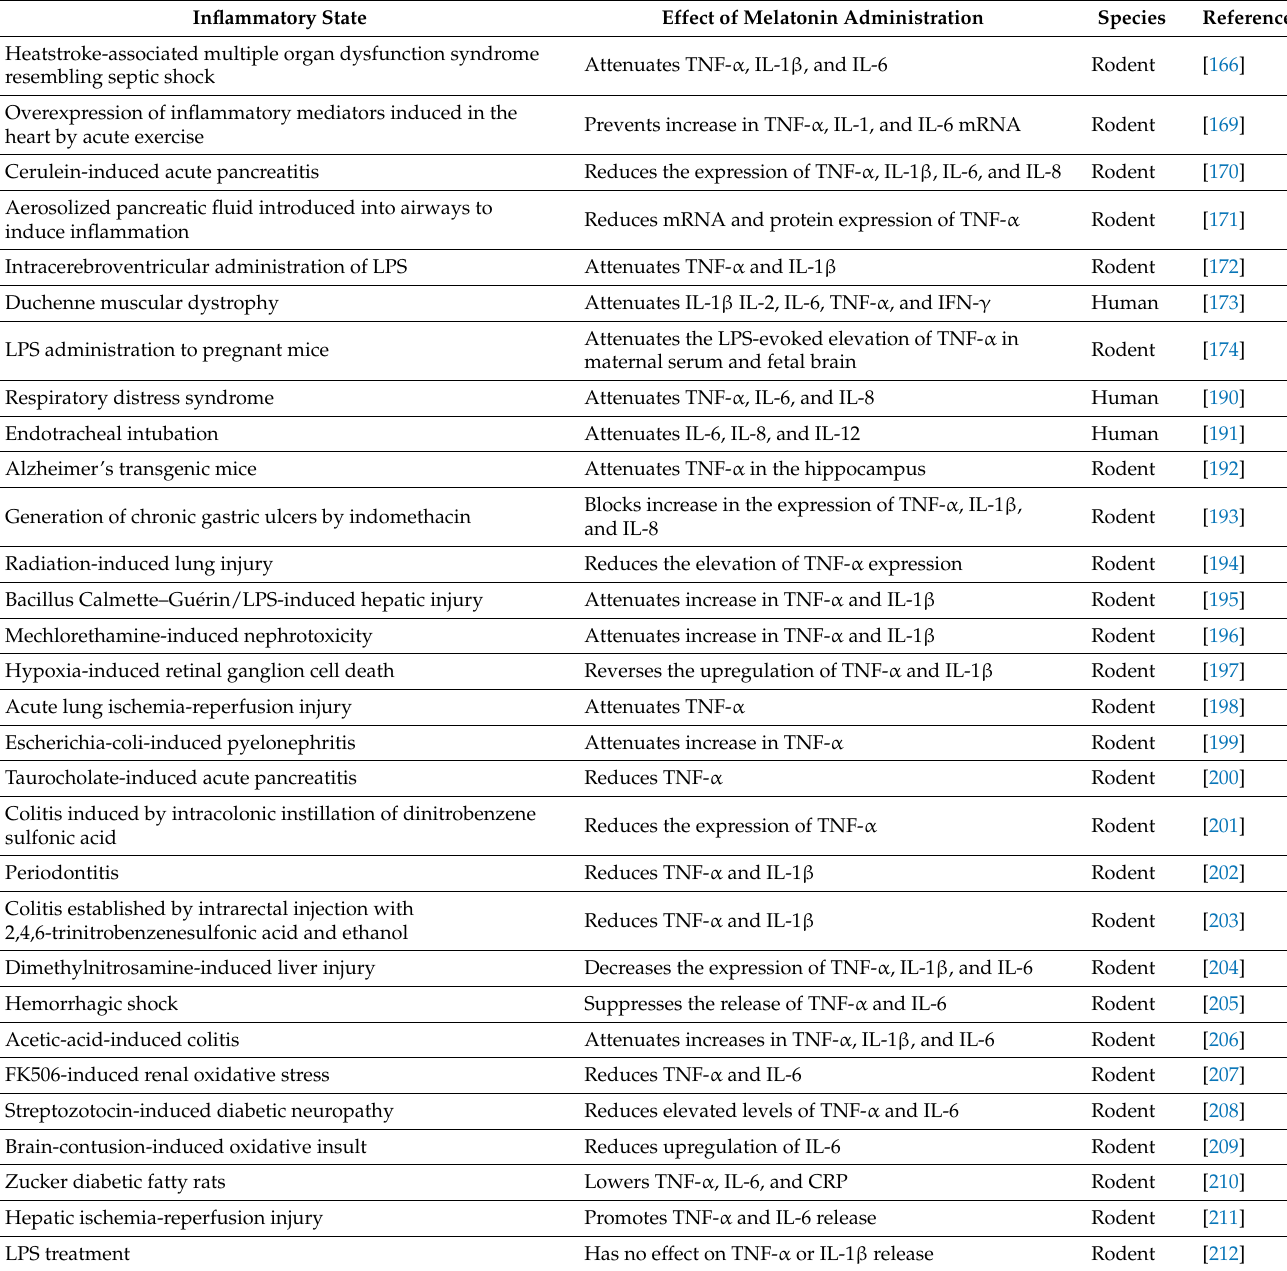
Table 1. Melatonin and pro-inflammatory cytokine production in an inflammatory